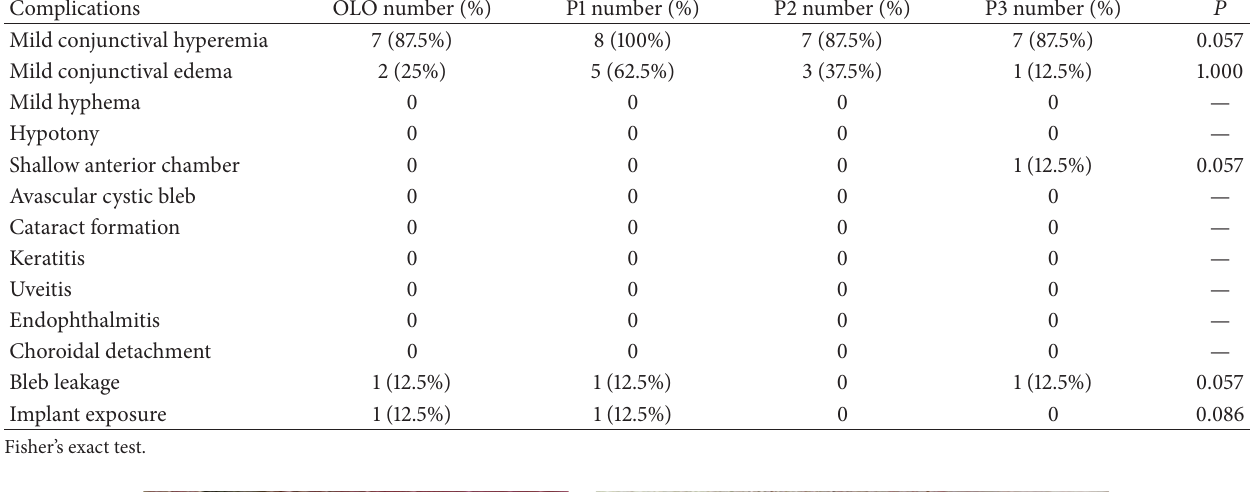
Table 2: Comparison of complications between the Ologen group and PTLGA terpolymer groups.